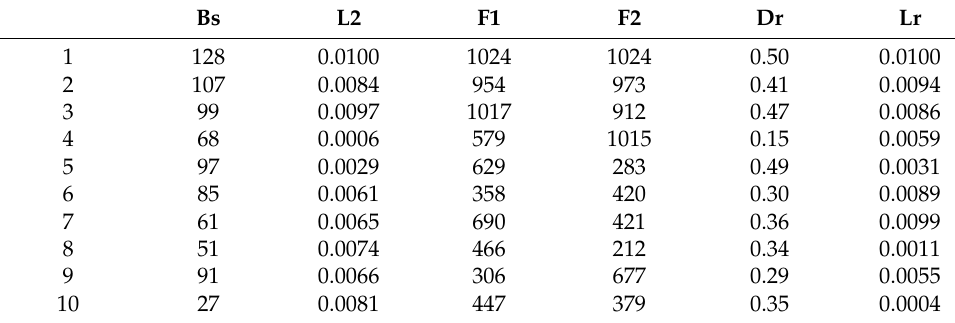
Table 12. Positions of individuals of SSA in the experiment on MNIST.